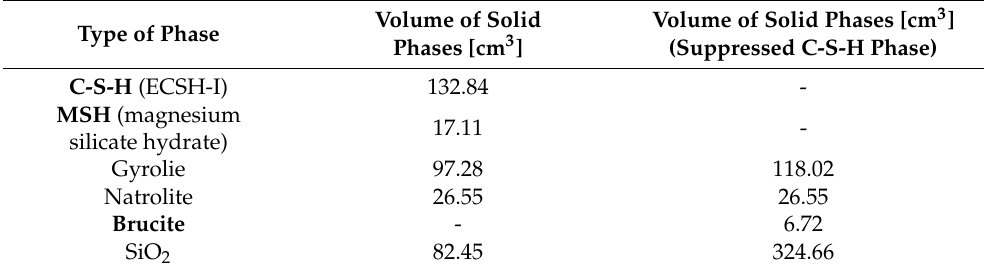
Table 3. Thermal dynamics (geochemical modeling, GEMS) simulation results obtained at 25 ◦ C.